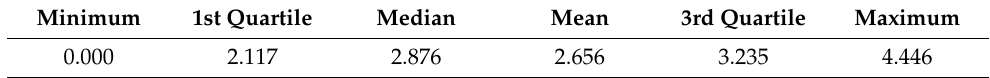
Figure 1. Pairwise sequence similarity of OBPs. Comparisons of a protein to itself are shown along the diagonal. The dendrogram shows the hierarchical clustering obtained from the complete linkage algorithm as implemented in the Python package Seaborn. Table 3. Summary of the calculated OBP sequence identities (values in